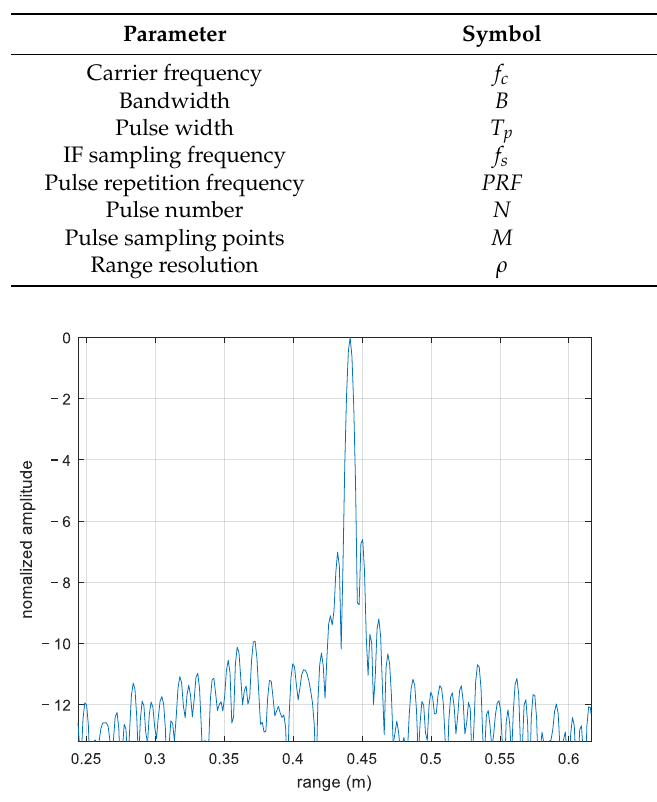
Figure 5. Normalized amplitude decibel value.